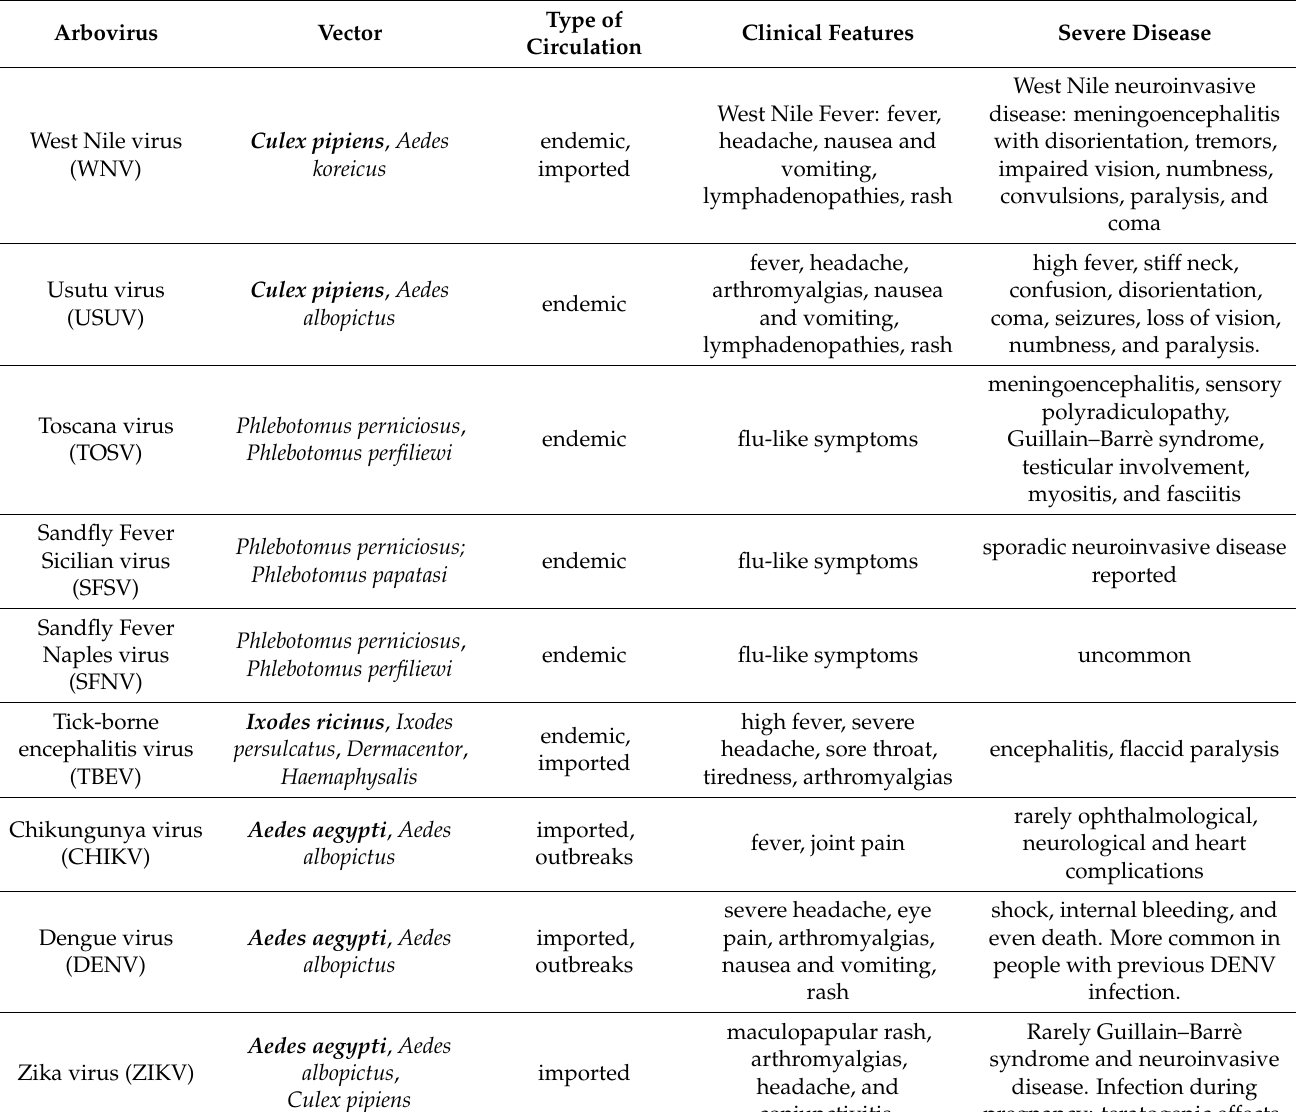
Table 1. Epidemiological and clinical characteristics of arboviral infections in